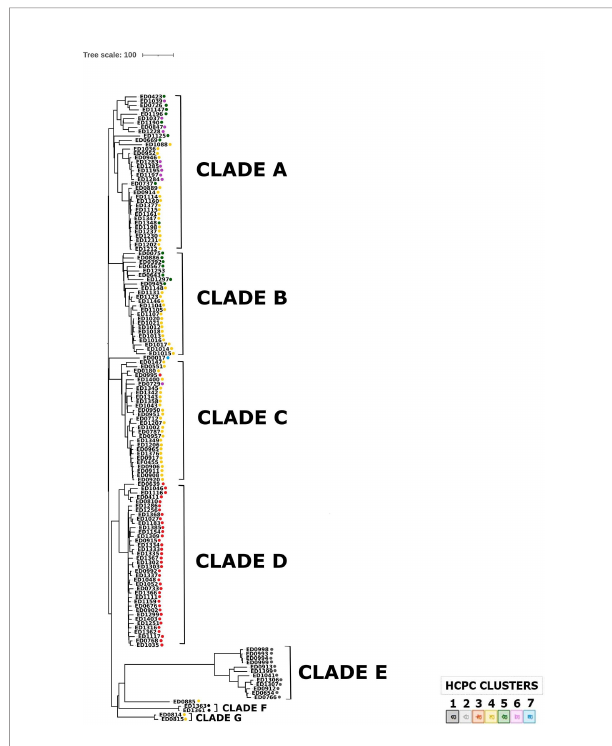
FIGURE 5 | Phylogenomic analysis of O26 STEC strains through cgMLST. The colors indicate the clusters attributed to each strain by HCPC